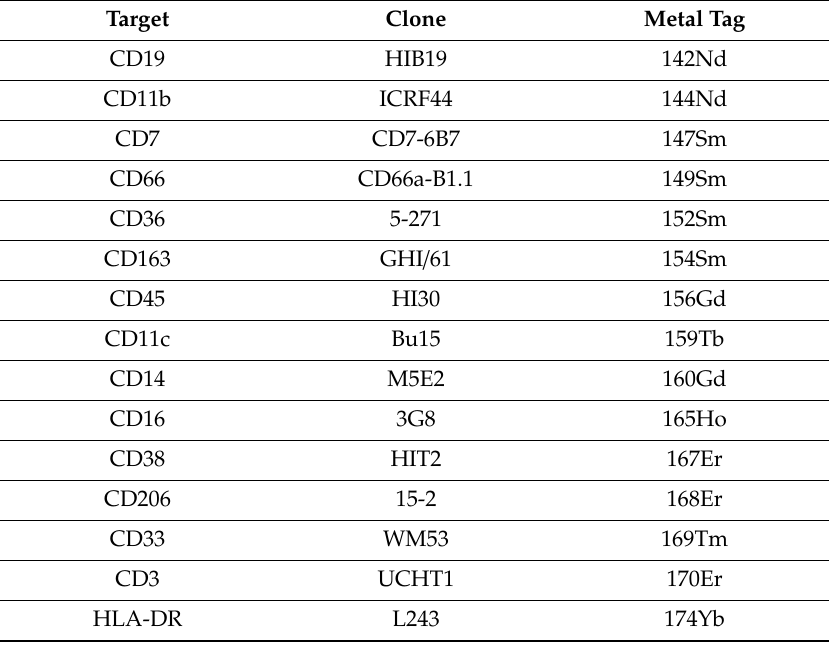
Table 3. List of the antibodies used for mass